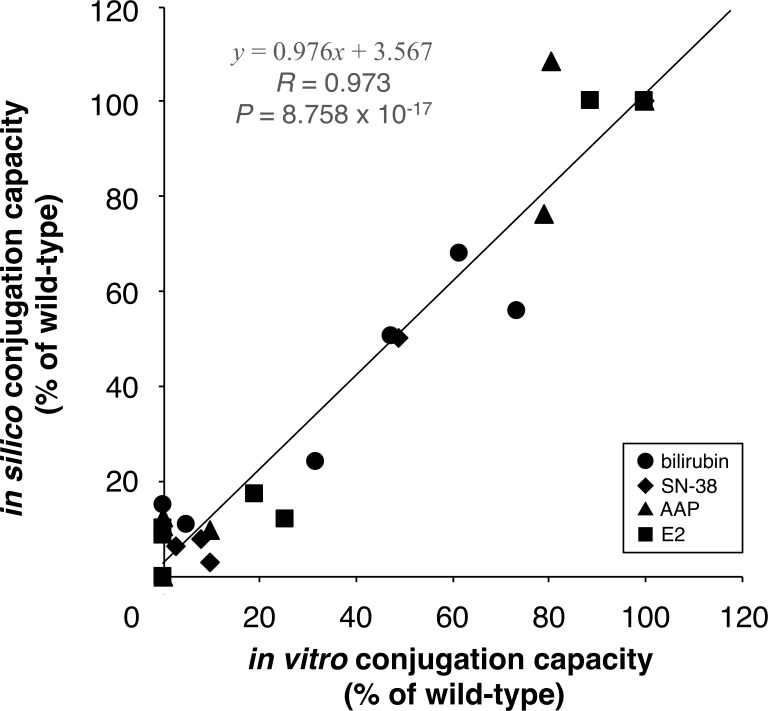
Correlation analysis between in silico and in vitro conjugation capacities.Regression equation (solid line), Pearson's correlation coefficient (R), and P value are shown.